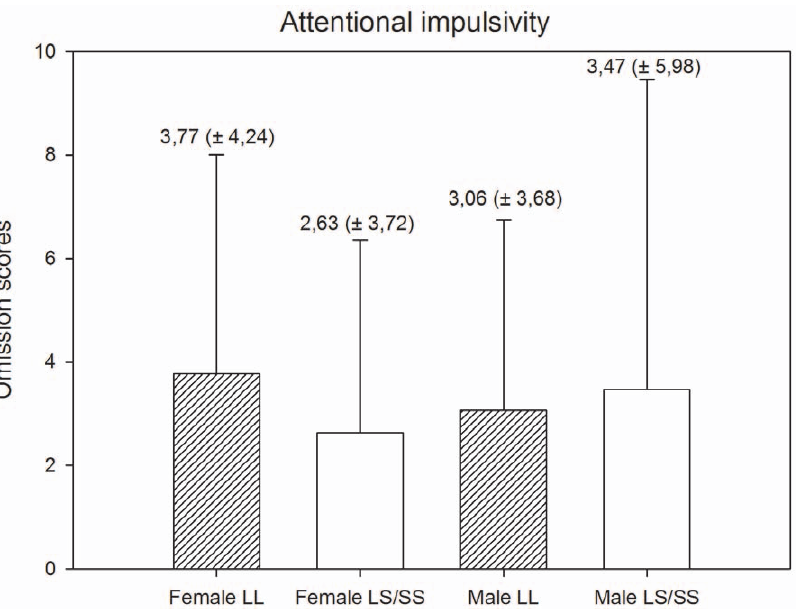
Figure 1. Attentional impulsivity scores and standard deviation of scores by gender and genotype.